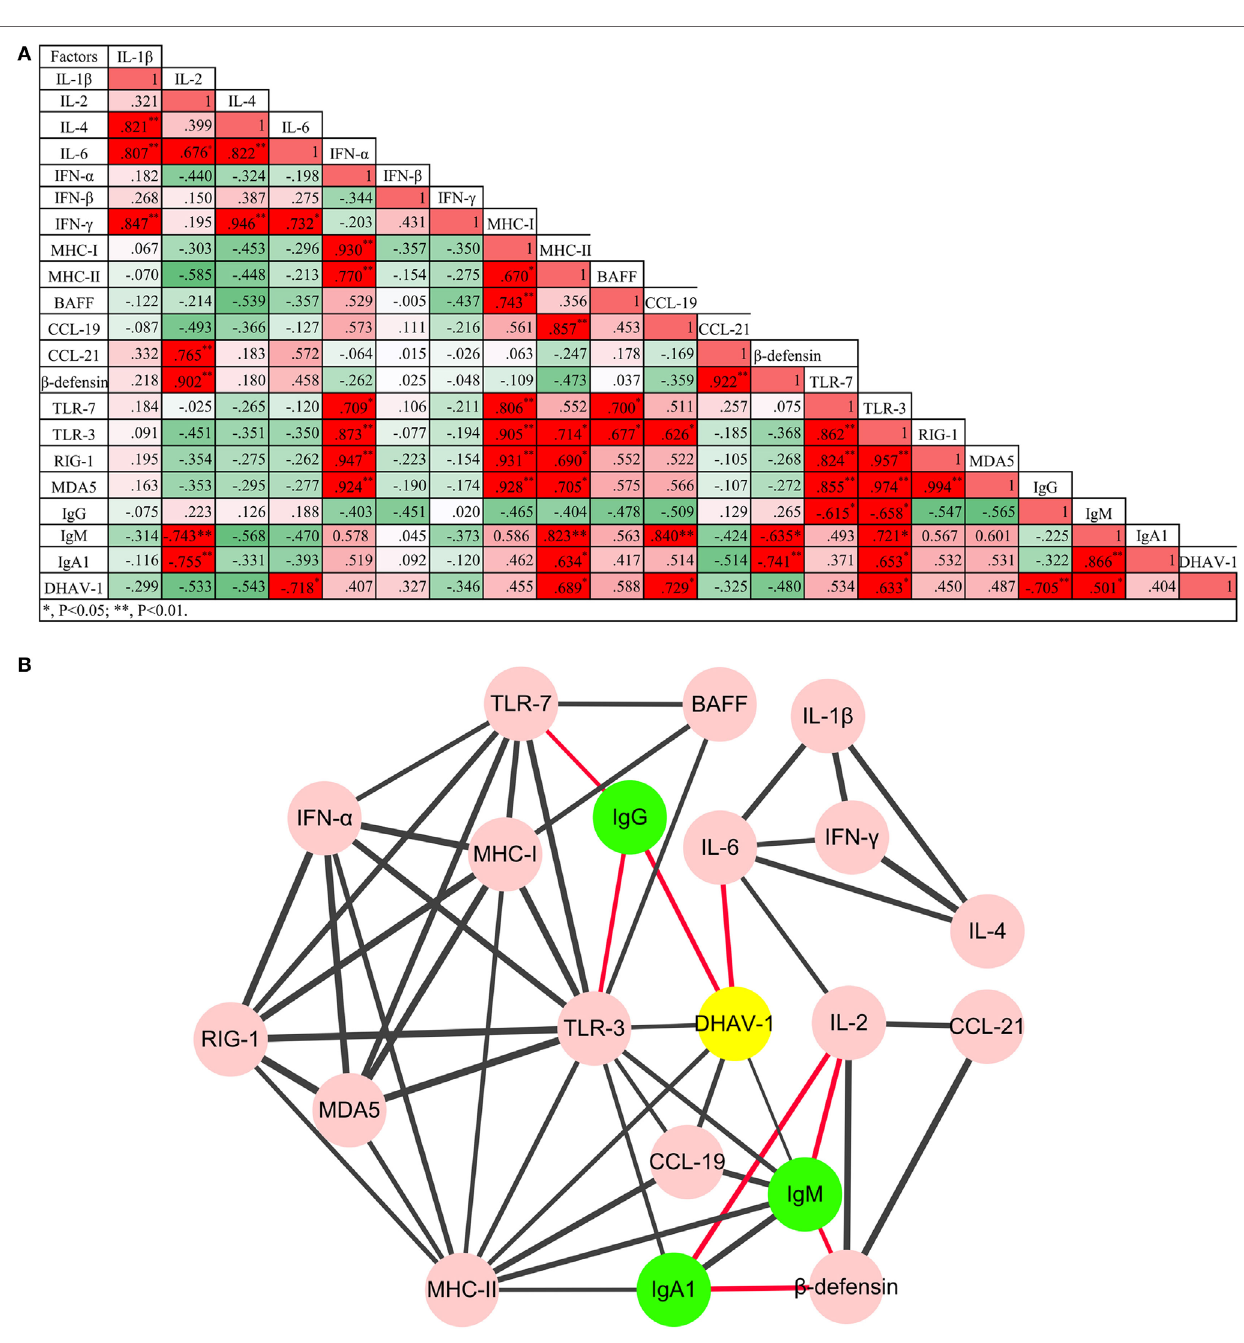
FigUre 4 | Regulatory networks of innate and humoral immune responses, and the game between duck hepatitis A virus 1 and the host immune system were (a) analyzed using Pearson correlation analysis and (B) visualized by Cytoscape software ( P < 0.05 at least). Red lines represent negative correlation, while the black lines represent positive correlation. The thickness of the border represents the intensity of the